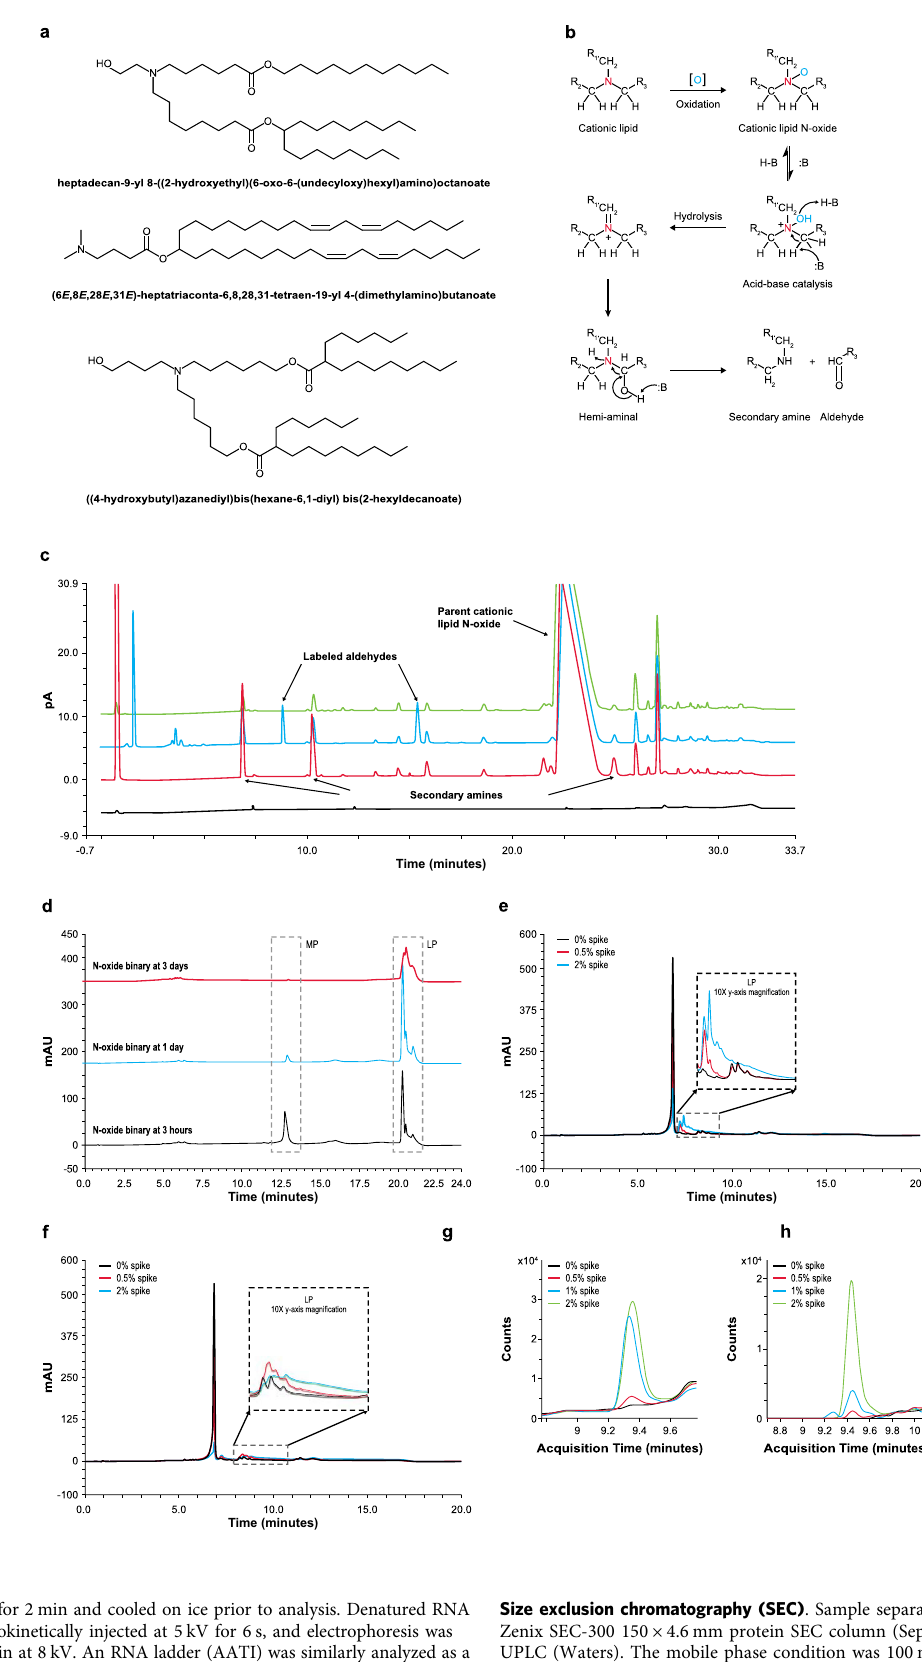
denatured at 70 °C for 2 min and cooled on ice prior to analysis. Denatured RNA samples were electrokinetically injected at 5kV for 6 s, and electrophoresis was performed for 40min at 8 kV. An RNA ladder (AATI) was similarly analyzed as a calibrator for nucleotide size. Data were analyzed using PROSize 2.0 software (Agilent